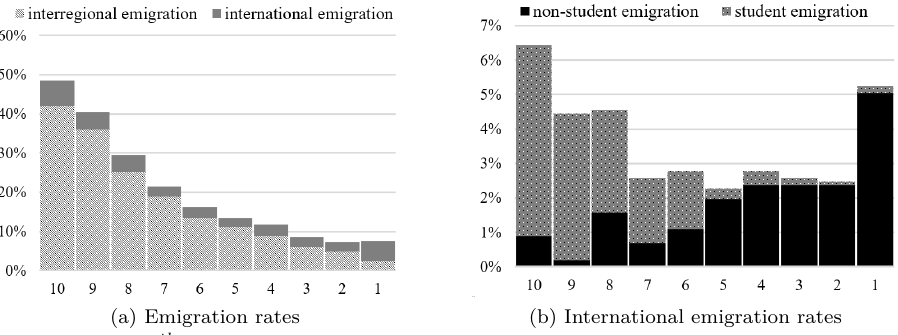
Figure 3: Migration rates across exam results deciles: emigration rate (a) and international emigration rates (b), with its components REGION : Volume 8, Number 1,